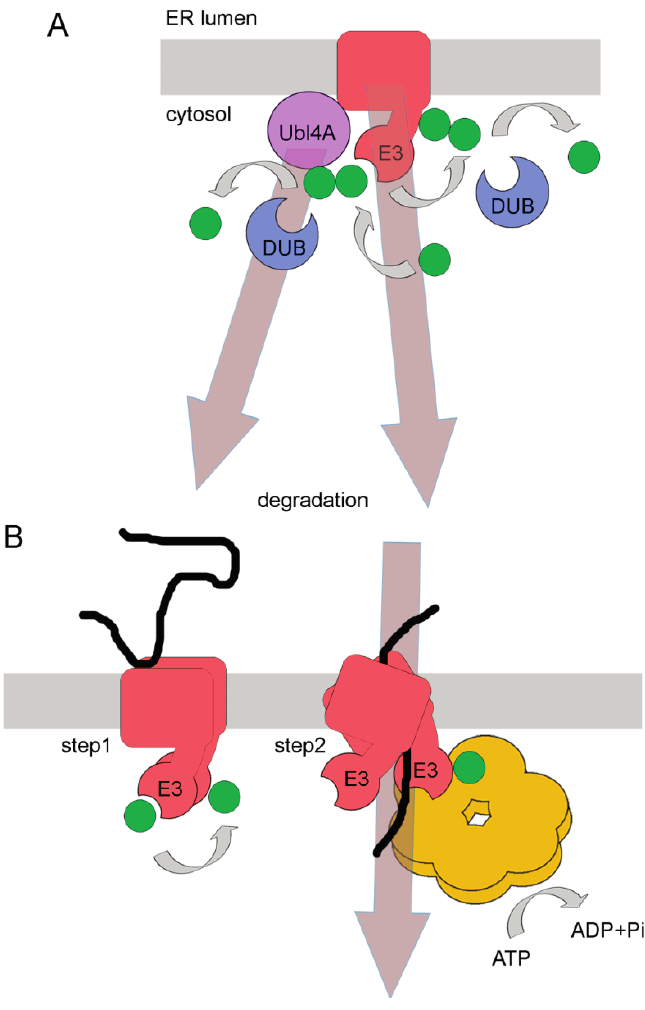
Figure 5. Models for ubiquitination and deubiquitination of ERAD machinery components as a mechanism to regulate ERAD. ( A ) Regulation through degradation. In the mammalian system, ubiquitination of the ERAD component Ubl4A by the E3 ligase gp78 leads to the degradation of the associated shuttling chaperone Bag6, thereby reducing efficient substrate targeting to the proteasome. Ubl4A ubiquitination is reversed by the DUB Usp13. A similar mechanism involves the self-ubiquitination of Hrd1p in yeast in absence of Hrd3p and Usa1p, leading to effective degradation of the E3 ligase. No DUB is currently known in this system. See text for details. ( B ) Regulation through conformational